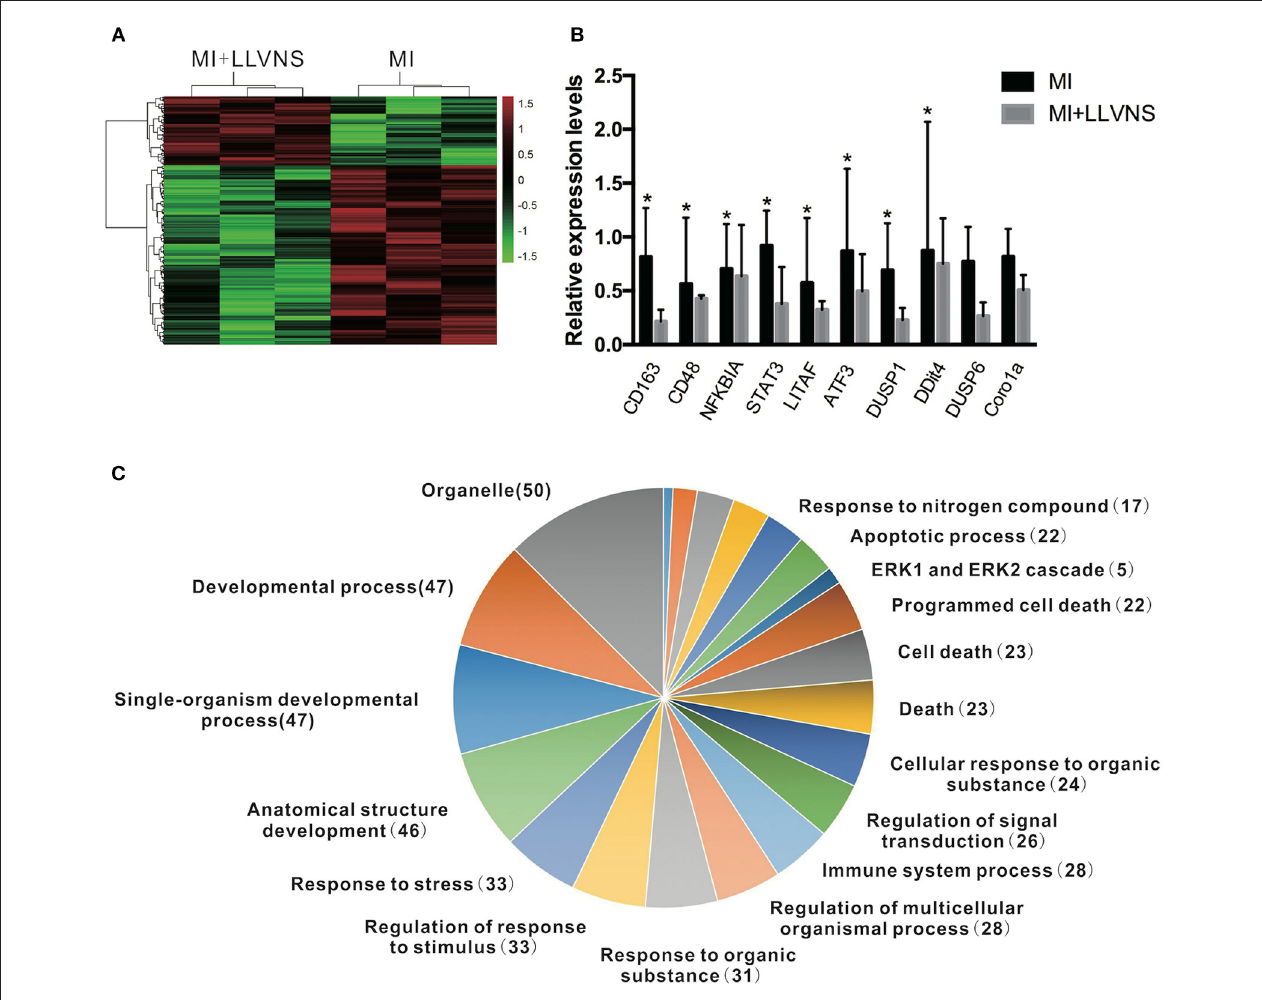
FIGURE 4 | LLVNS regulates the expression of genes. (A) The heat map of DEGs in the cardiac tissue ( p < 0.05, 1.5 fold or more) between the MI and MI + LLVNS groups. (B) The verification of some DEGs identified in microarray analyses by RT-PCR analyses. (C) A pie chart of gene ontology clustering for the DEGs shown in (A) . * p < 0.05. DEGs, differentially expressed genes; LLVNS, low level left vagus nerve stimulation; MI, myocardial infarction. MI group ( n = 6), MI + LLVNS group ( n =